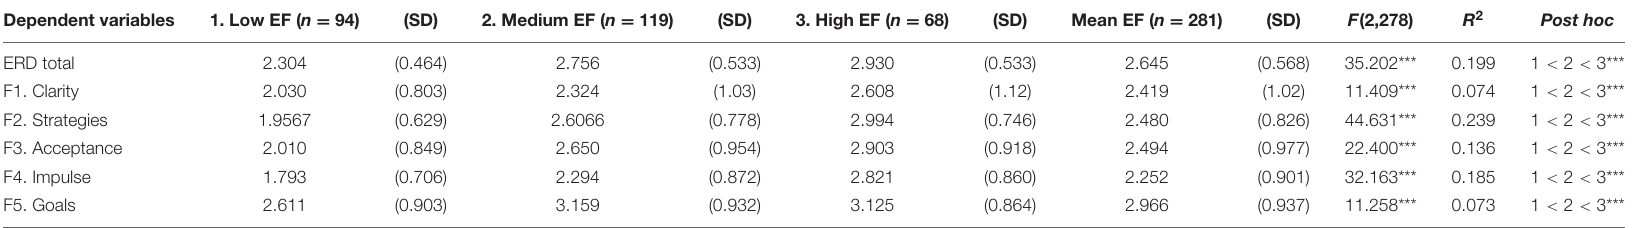
TABLE 10 | Effect of low–medium–high levels of the independent variable executive dysfunctions (EF) on emotion regulation difficulties (ERD). Dependent